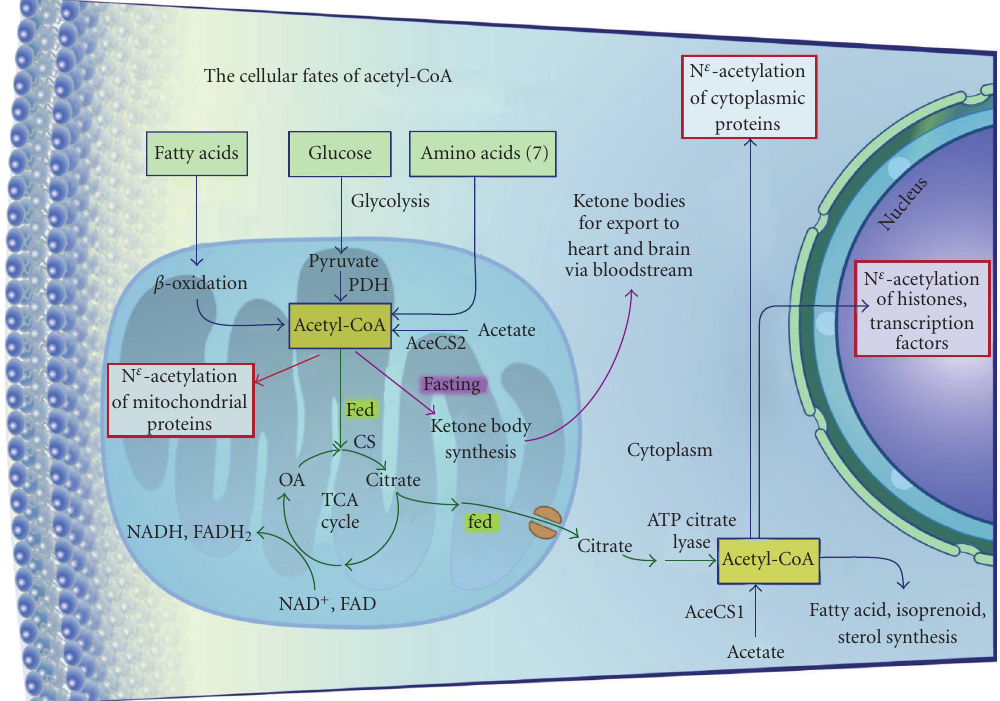
Figure 1: The cellular fates of acetyl-CoA. Please see section entitled “Acetyl-CoA and Metabolism” for a detailed description of the figure. PDH: pyruvate dehydrogenase complex, AceCS2: acetyl-CoA synthetase 2, CS: citrate synthase, OA: oxaloacetate, AceCS1: acetyl-CoA synthetase